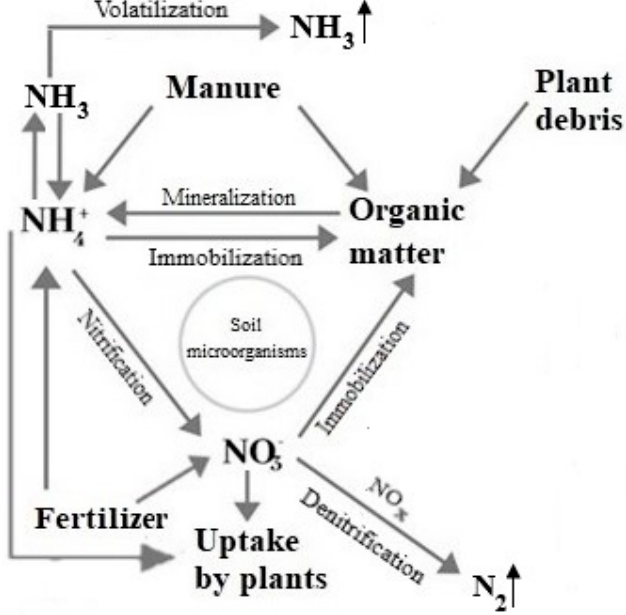
Figure 1. The course of mineralization of nitrogen compounds. Compiled by the author.